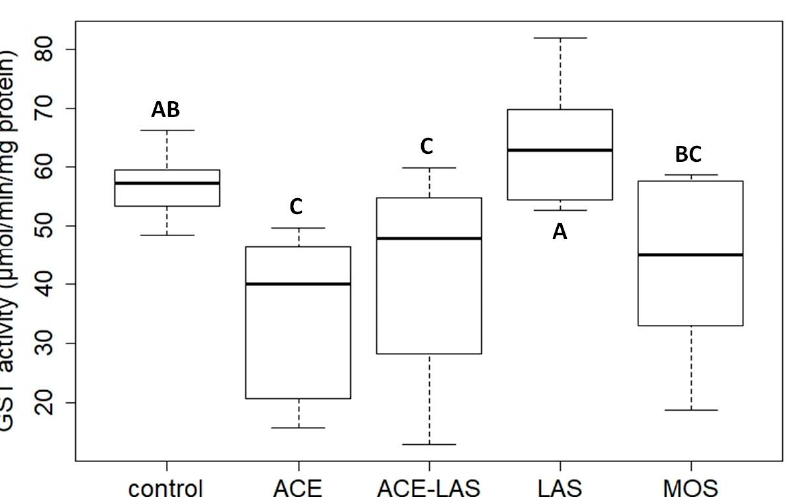
Figure 6. Activity of glutathione S-transferase (GST) enzyme in D. magna juveniles exposed to M ospilan 20 SG (MOS) and its components (active ingredient (acetamiprid (ACE)) and formulating agent (linear alkylbenzensulfonates (LASs))) individually and in combinations at concentrations equivalent to one third of the calculated 48 h EC 50 values according to the results originated from immobilization tests. Combined toxicity of the investigated components was investigated in the form of their pure mixture (ACE-LAS) and formulated insecticide (MOS).